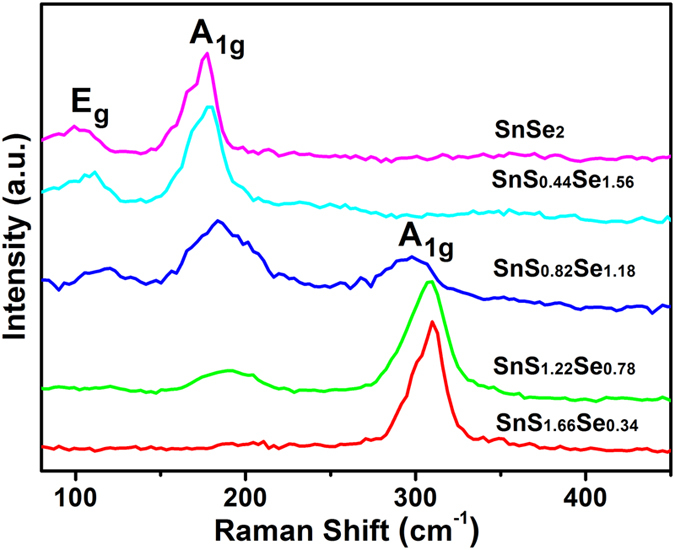
Raman spectra of SnS2−xSex alloys with different x values.